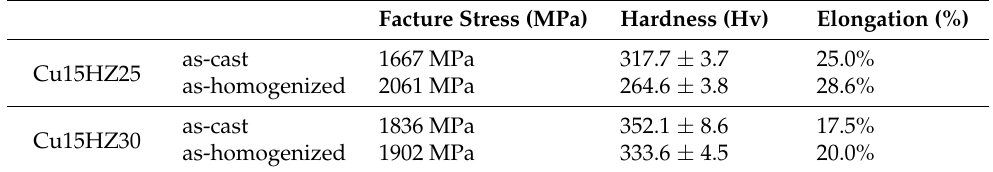
Table 3. Mechanical properties of as-cast and as-homogenized states of Cu15HZ25 and